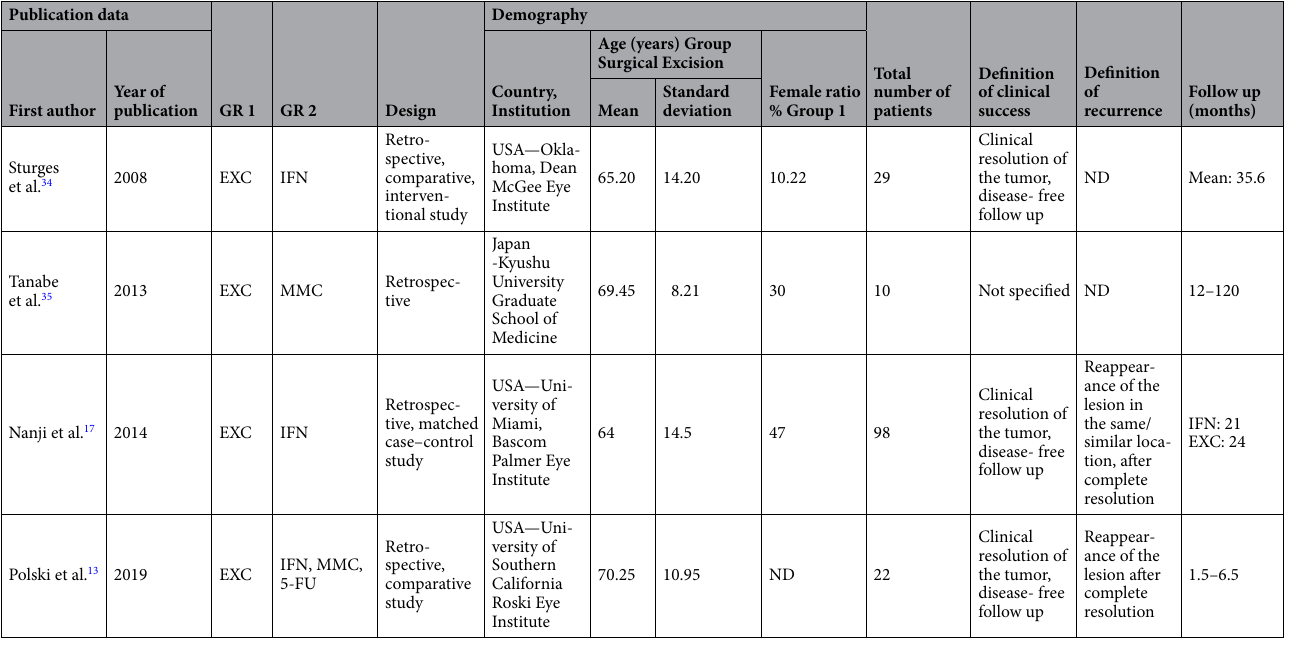
Table 1. Characteristics of studies included in the quantitative synthesis. ND no data, EXC surgical excision.